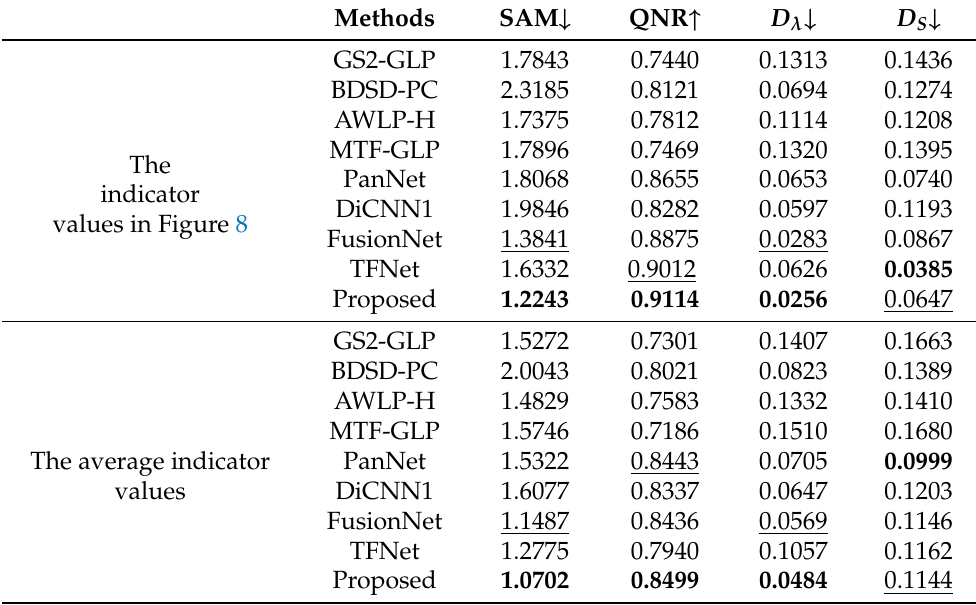
Table 9. Comparison of indicator evaluation results on the full-resolution Ikonos